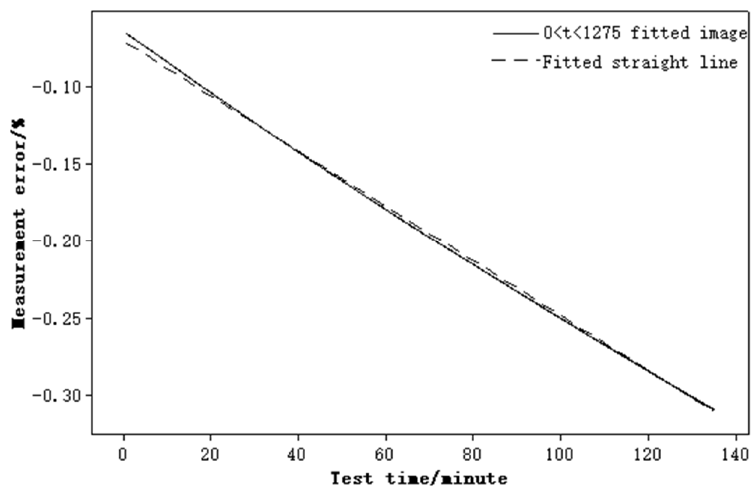
Figure 6. Measurement error growth model after time size transformation.